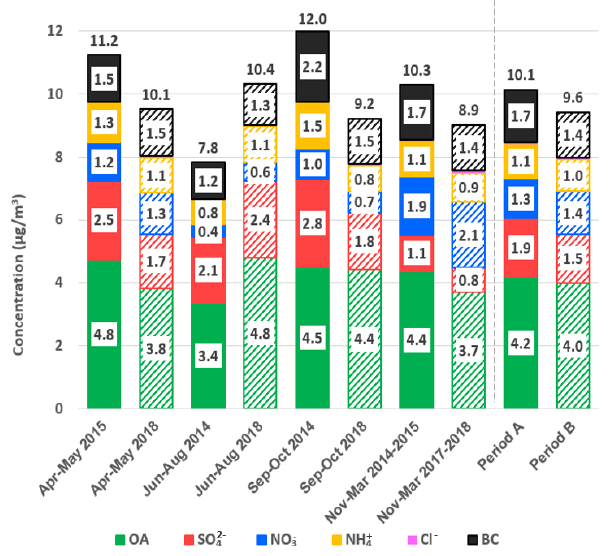
Figure 1. Seasonal bar plot of Q-ACSM species and BC mean con- centrations for periods A (with solid bars) and B (with weft bars).